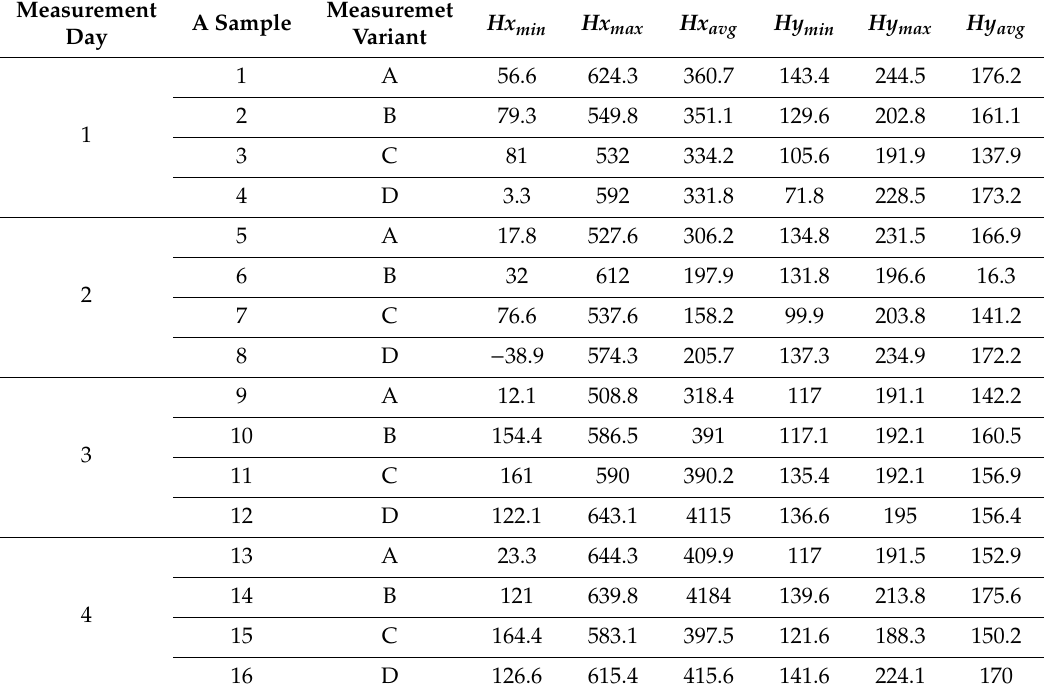
Table 1. Minimum, maximum, and average values of tangential and normal component of the magnetic signals for experiments